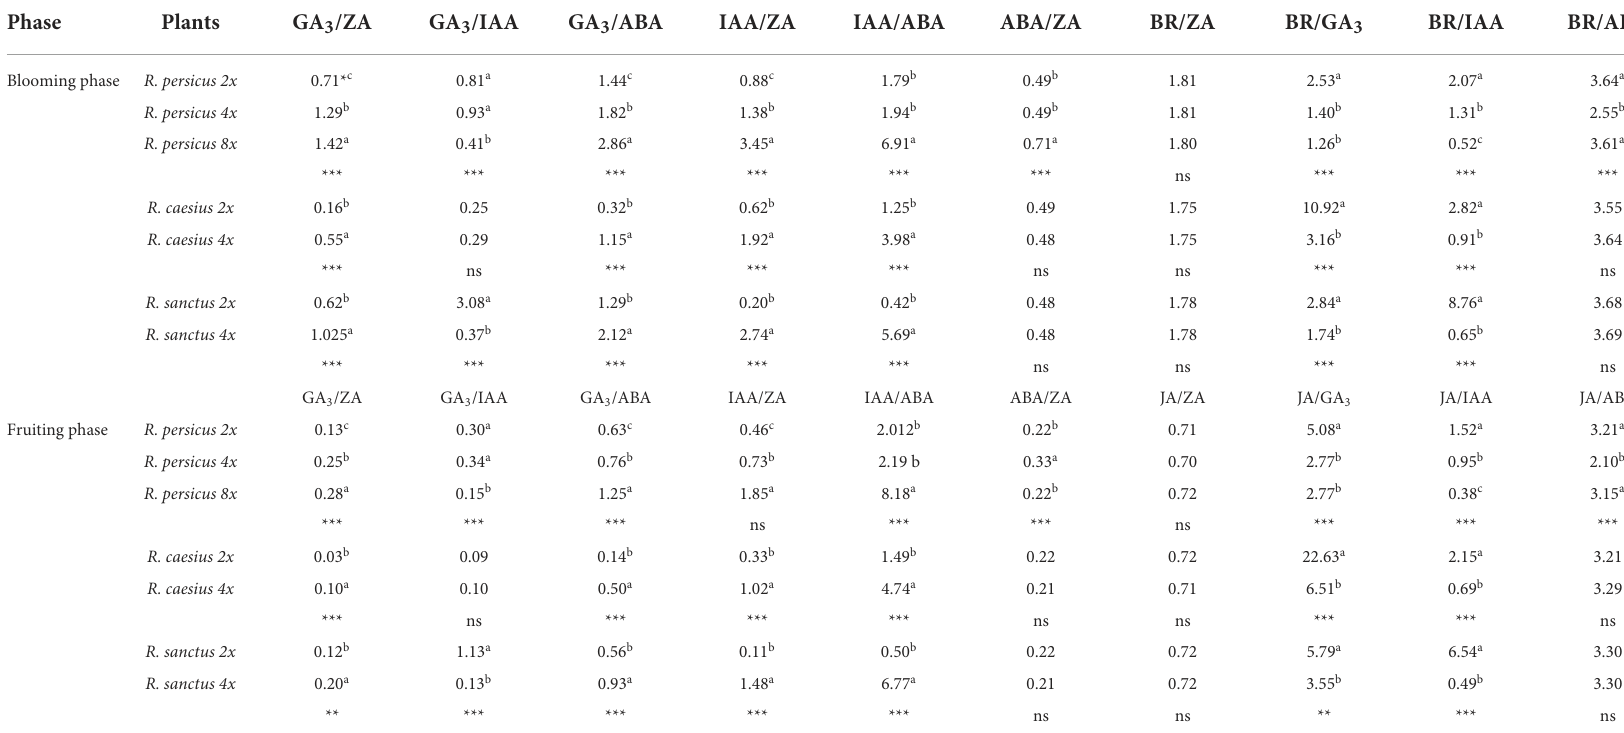
TABLE 3 The mean comparison of phytohormones ratio in diploid and polyploid plants of three blackberry species at flowering and fruiting phase. Phase Blooming phase R. persicus 2x